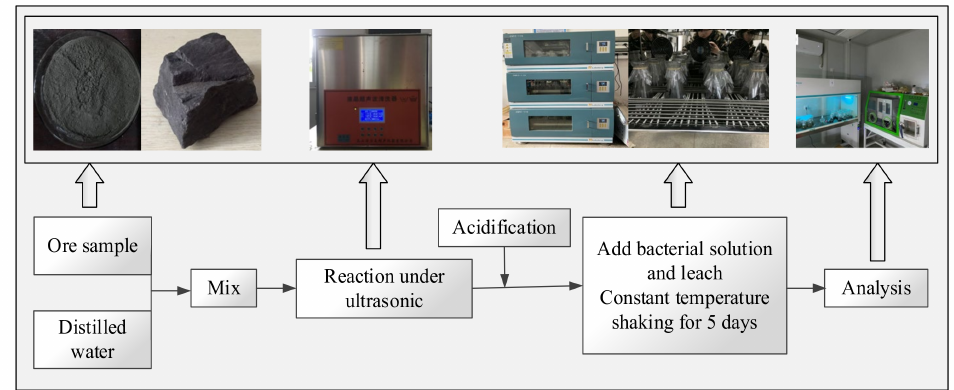
Figure 3. The experimental flow of microbial desulfurization experiments of sulfide ores using ultrasonic